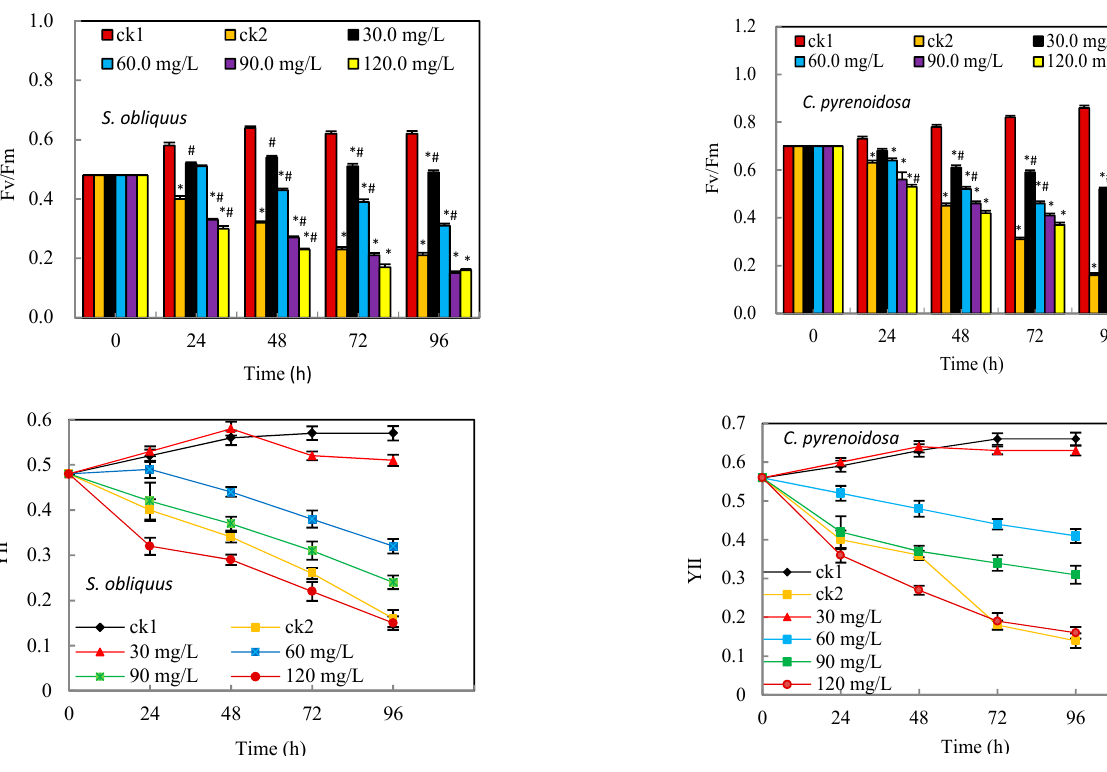
Figure 2. Effects of salicylic acid on the Chlorophyll fluorescence parameters of S. obliquus and C. pyrenoidosa under Cd 2+ stress. Note: * means there is statistical significance compared with the ck1 group at the same period, p < 0.05; # means there is a statistical significance compared with the ck2 group at the same period, p < 0.05.